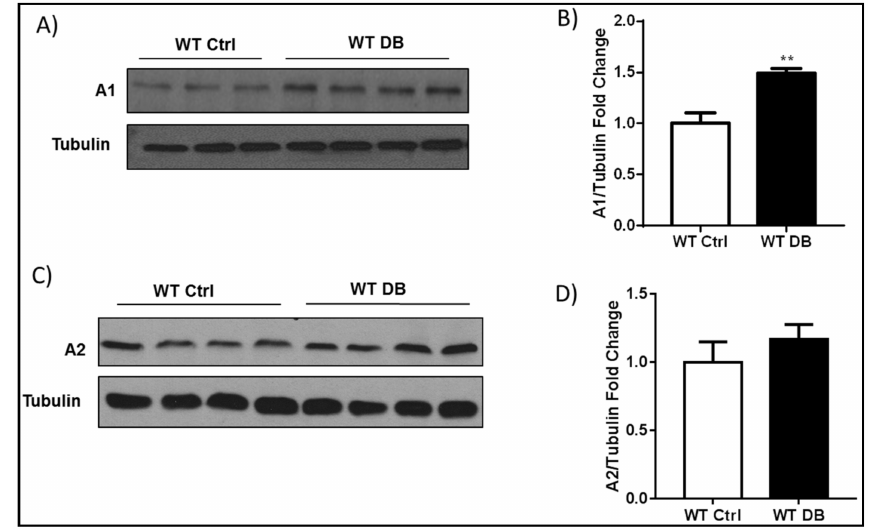
Figure 1. Diabetes induces increases in arginase 1 (A1) expression. ( A ) Western blot analysis and quantification ( B ) showing increased A1 expression in wild type (WT) diabetic retinas. ** p < 0.01 vs. WT Ctrl. n = 3–4; ( C ) Western blot analysis and quantification ( D ) show similar levels of A2 expression in WT diabetic mice and age matched controls. p = 0.4, n =